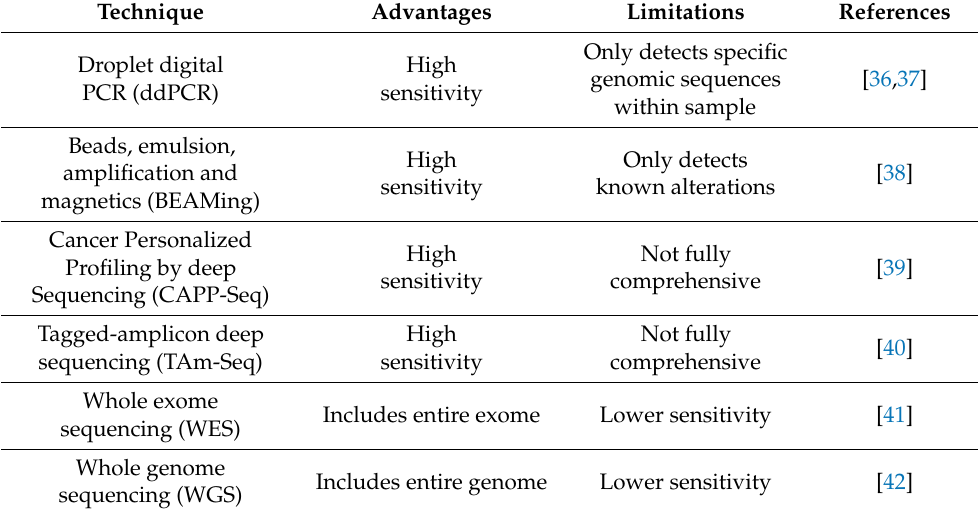
Table 2. Examples of techniques to detect